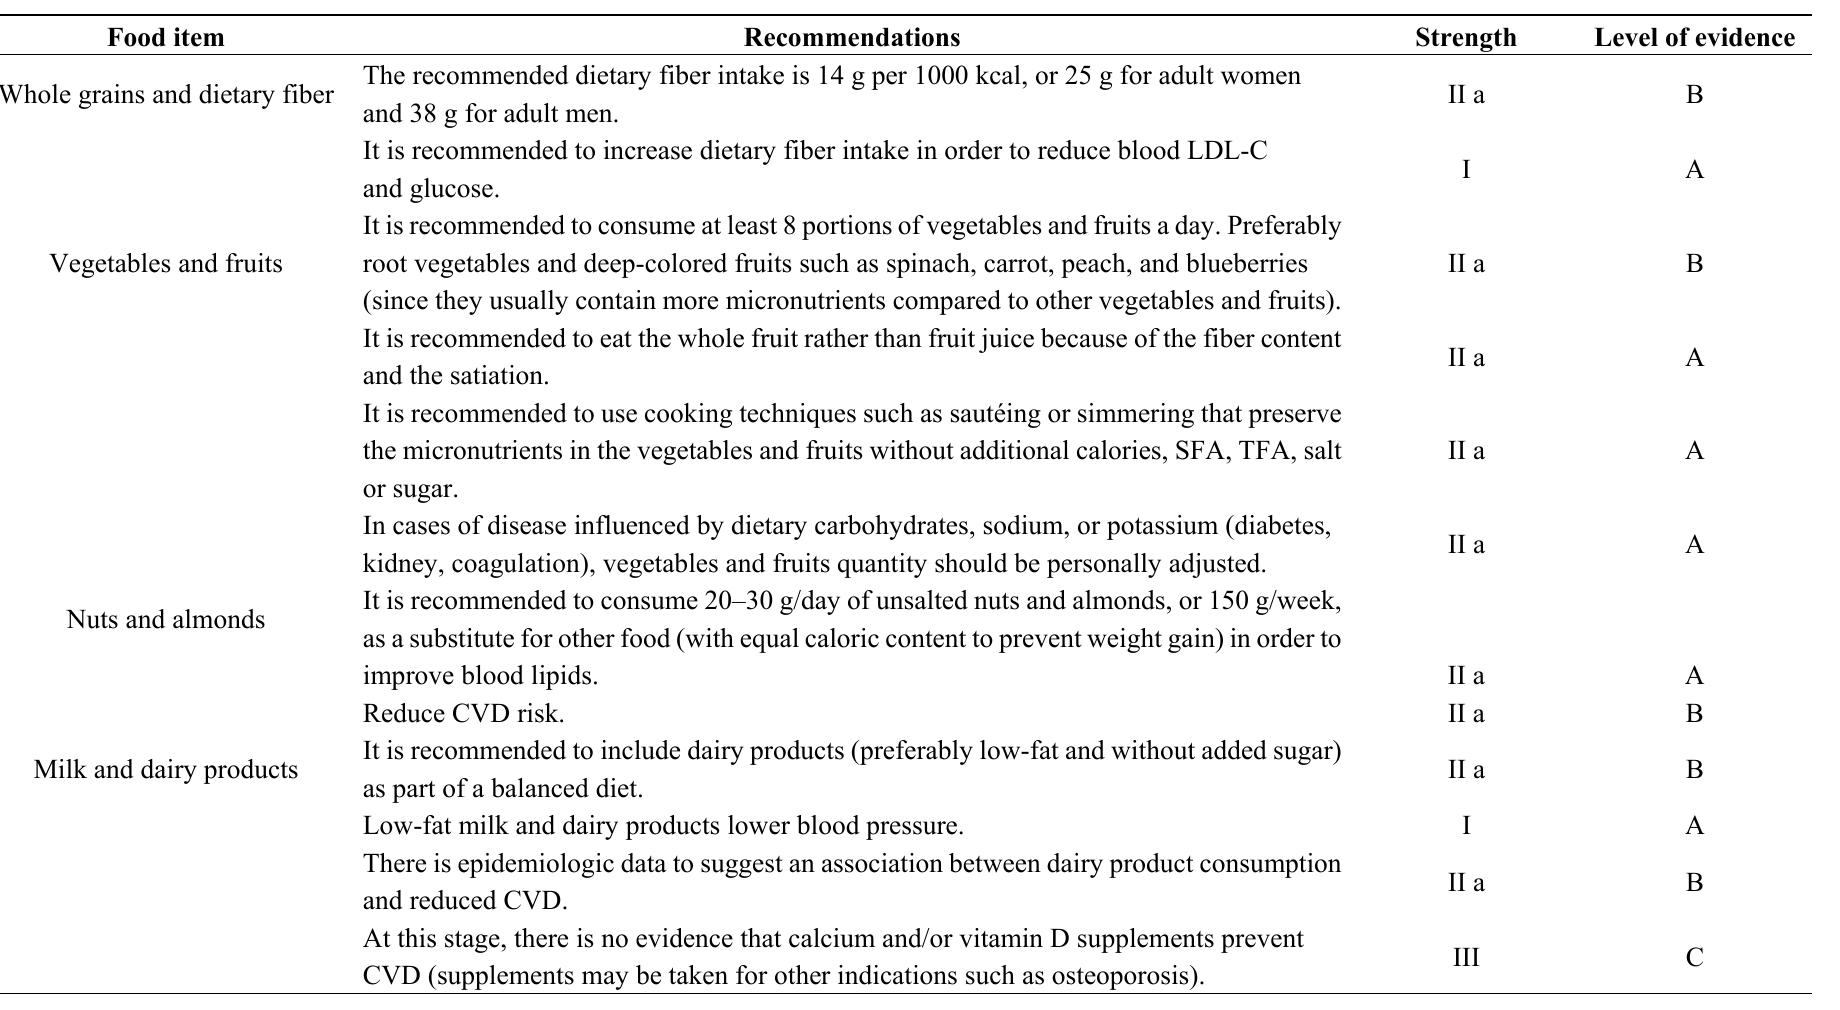
Table 7. Level of evidence and classes of recommendations for food